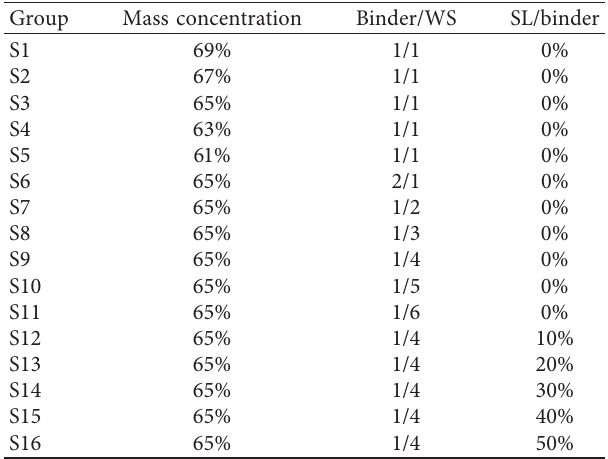
Table 2: Basic physical properties of the waste sediment. Property